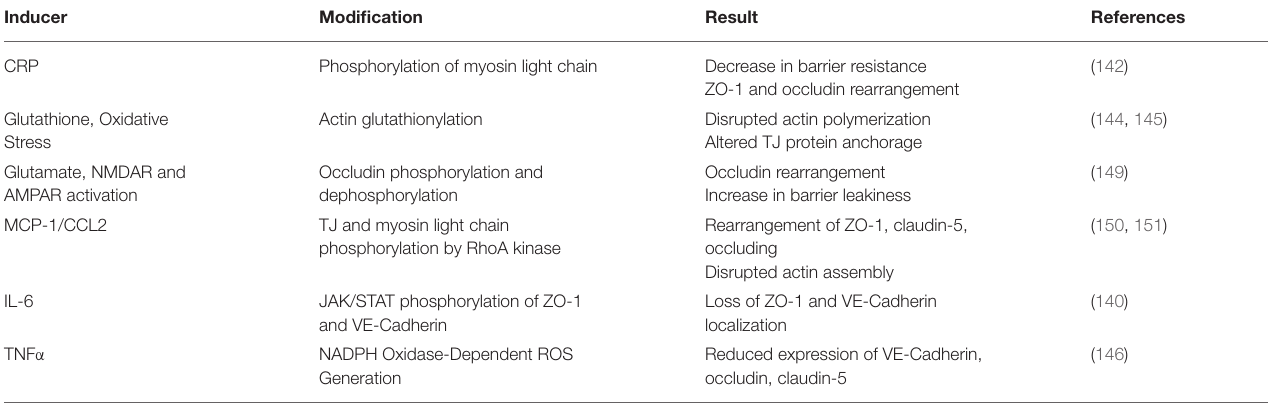
TABLE 4 | Cytoskeletal modifications leading to changes in TJ/AJ function and barrier permeability.